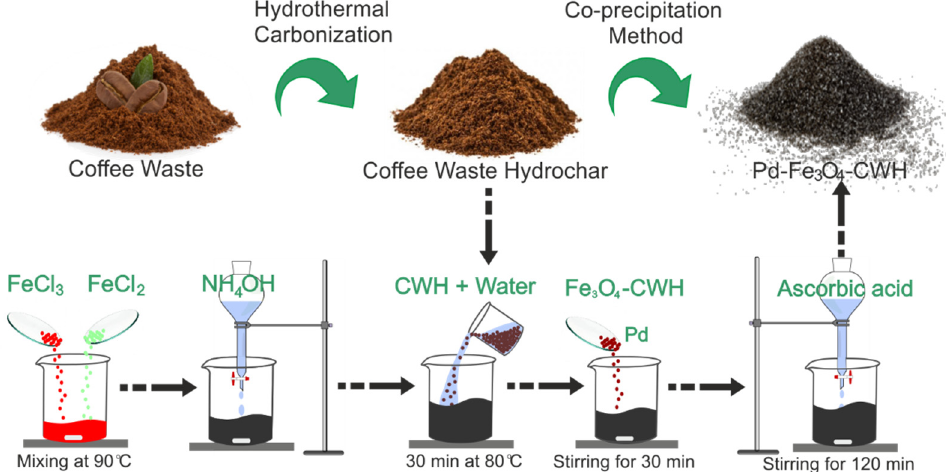
Figure 1. Schematic diagram of the Pd-Fe 3 O 4 -CWH catalyst preparation.